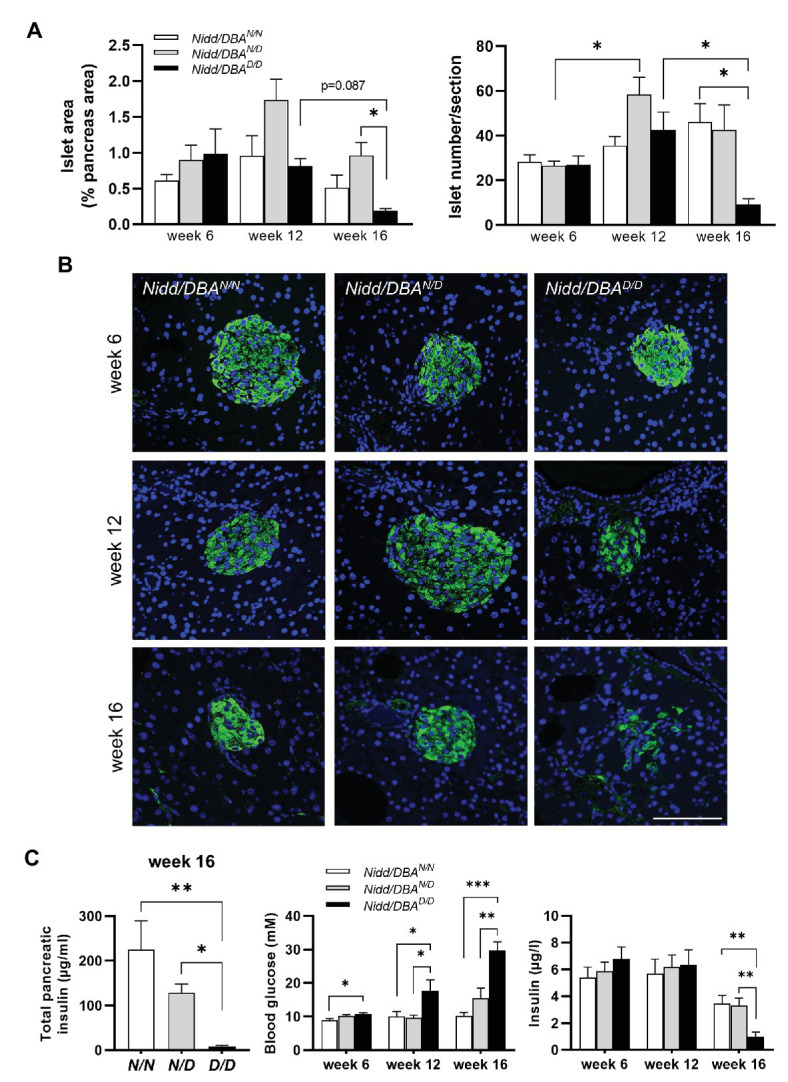
Nidd/DBA mice exhibited marked β-cell loss and islet destruction. (A) Quantification of islet area (left panel) and islet number/section (right panel) at the indicated time points in male Nidd/DBAN/N (N/N), Nidd/DBAN/D (N/D), and Nidd/DBAD/D (D/D) mice (n = 3–8 animals/genotype). (B) Representative images of pancreatic sections of male Nidd/DBA (RCS-I) mice stained for insulin (green). Nuclei were stained with DAPI (blue); Scale bar: 100 μm. (C) Pancreatic insulin content in congenic mice (RCS-I) at the age of 16 weeks (n = 5–7) and 6 h fasting blood glucose and insulin values in RCS-I mice at different time points (N/N, n = 5–19, N/D, n = 6–35, D/D, n = 10–20). Data are presented as means ± SEM and were analyzed by one-way ANOVA. *p < 0.05; **p < 0.01; ***p < 0.0005.